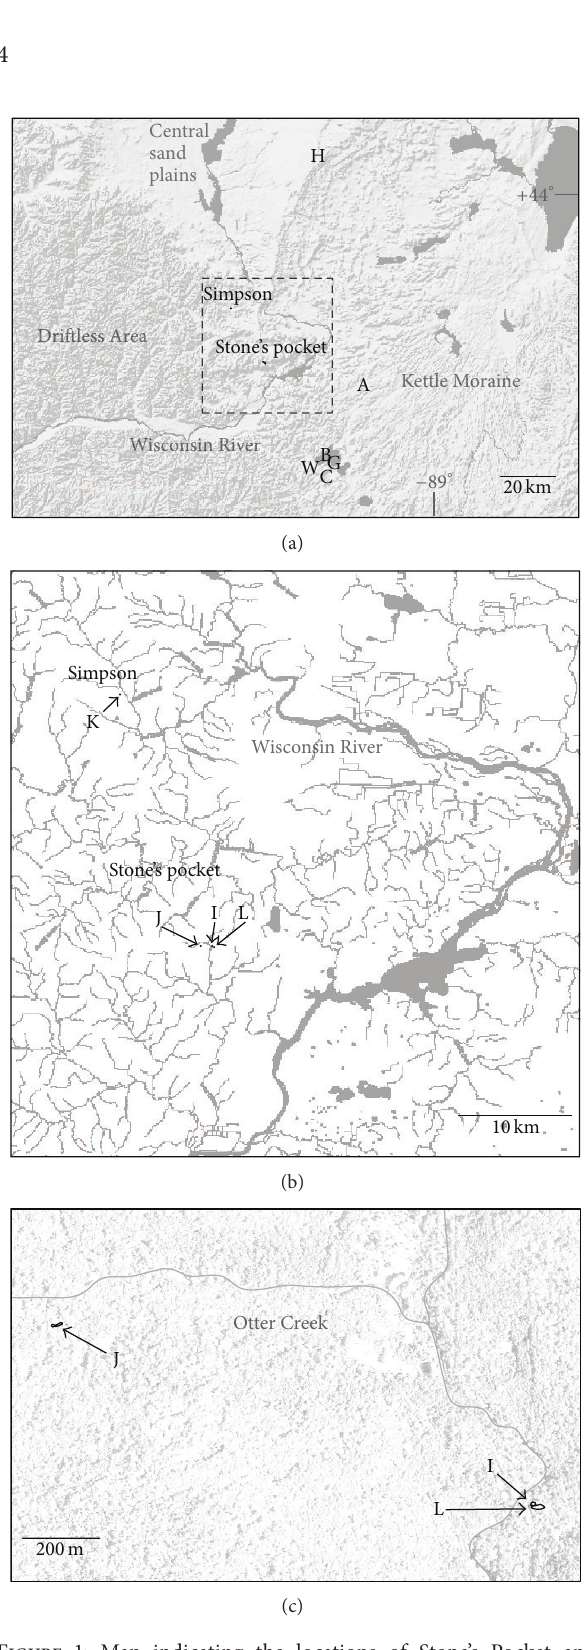
Figure 1: Map indicating the locations of Stone’s Pocket and Simpson, the two localities sampled over time in this study. (a) Map of central Wisconsin including the sampling sites labeled A, B, C, G, H, and W that were sampled previously. (b) Close-up of the area outlined in map A. Plots L, I, J, and K were sampled in this study. (c) Close-up of sampling plots at the Stone’s Pocket